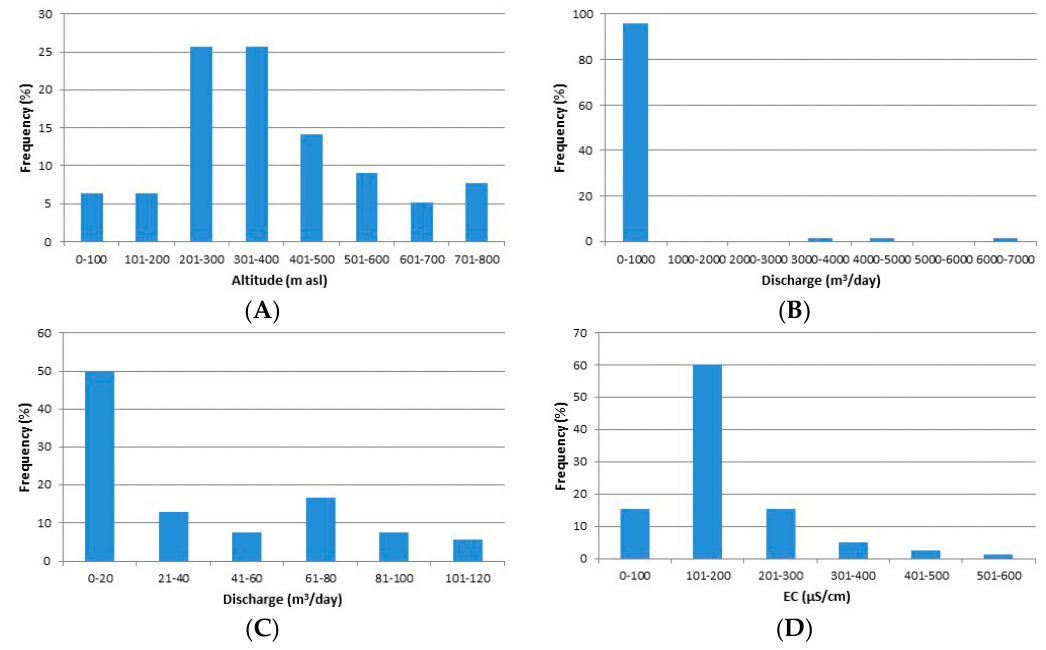
Figure 3. Attributes of the sampled springs according to: ( A ) altitude range; ( B ) discharge—all springs; ( C ) discharge—springs with values lower than 120 m 3 /day; ( D ) water electrical conductivity.